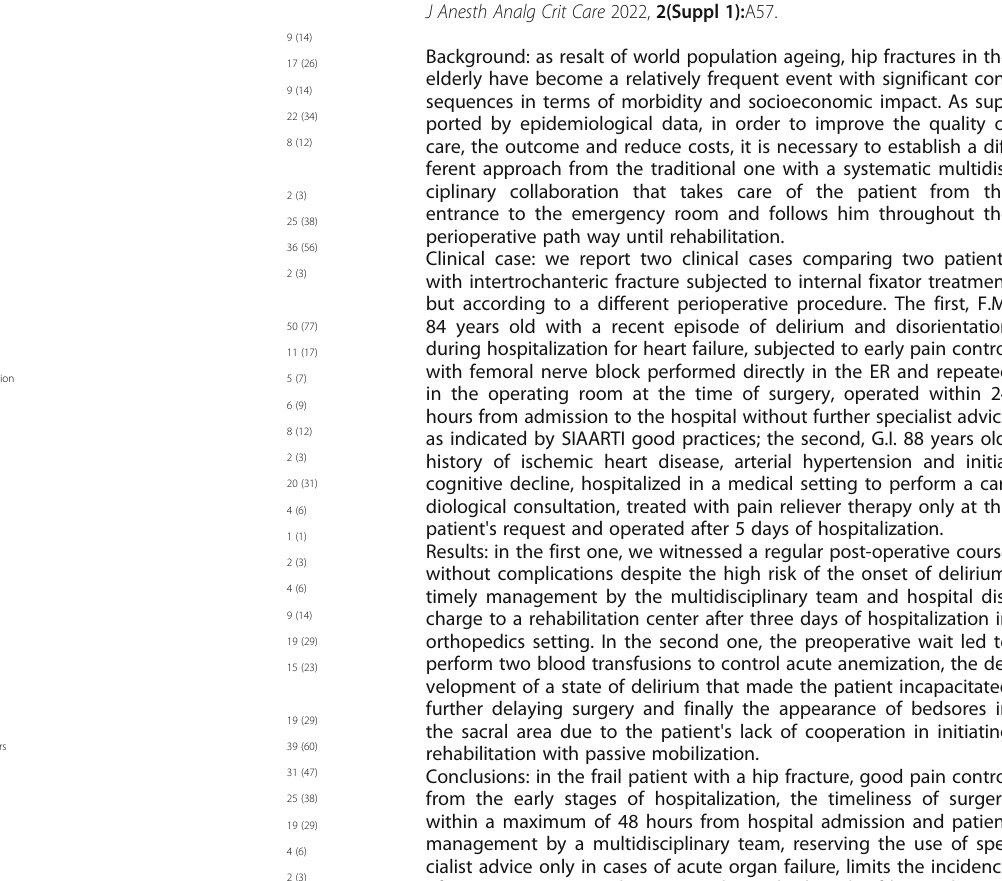
A57. Proximal femur fracture in the fragile patient: case report on relevance to SIAARTI good practices Pieri S., Pepe M. Azienda usl Toscana Sud Est Dipartimento Emergenza Urgenza UOC Anestesia e Rianimazione ~ Arezzo ~ Italy Correspondence: Pieri S.